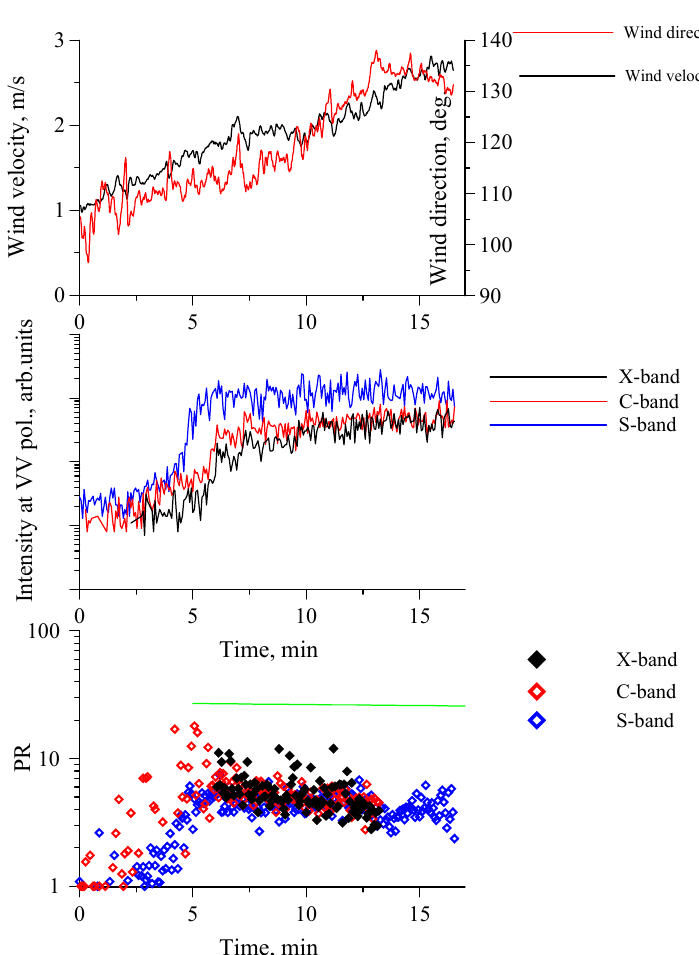
Figure 3. A case study of radar backscattering from the sea surface at growing wind velocity (top, black—wind velocity, red—direction), VV radar return (center, blue—C-band, red—S-band, black—X-band) and with polarization ratio (PR) variations (bottom, black symbols—X-band (multiband radar and X-band scatterometer), red symbols—S-band, blue—C-band); the ratio of R ( θ ) estimated according to the framework of the Bragg theory is denoted by the green line.